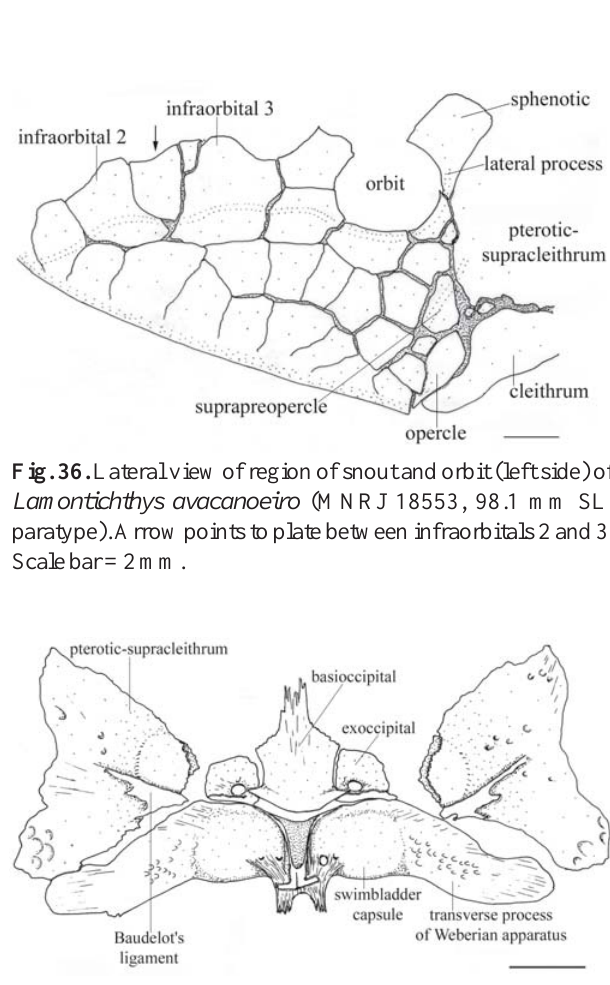
Fig. 37. Ventral view of posterior portion of neurocranium and anterior portion of Weberian apparatus of Rineloricaria sp. (MZUSP 23748, 91.5 mm SL). Bones were disarticulated to allow better visualization of features mentioned in the text. Scale bar = 2 mm.